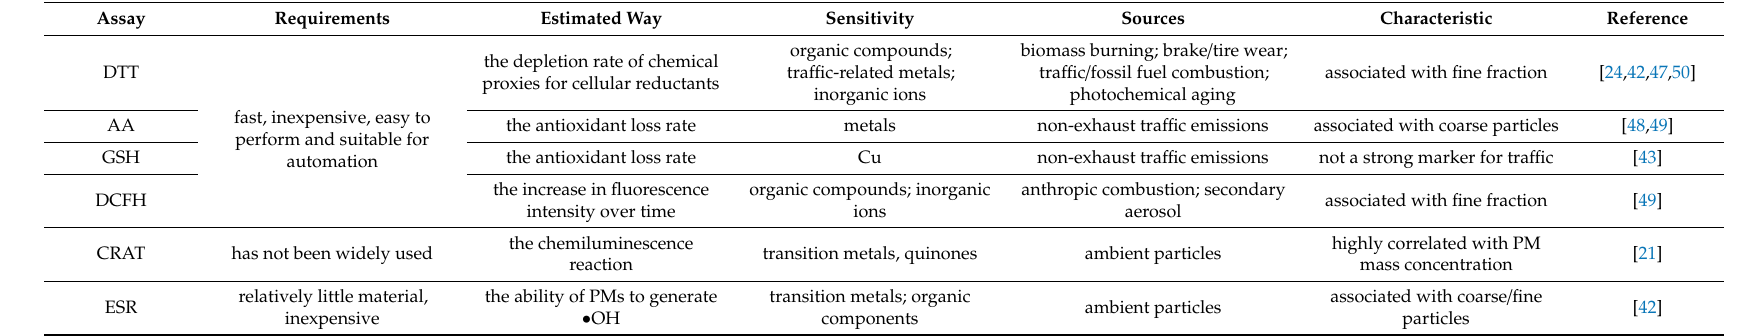
Table 1. Comparison of acellular assays to assess the oxidative